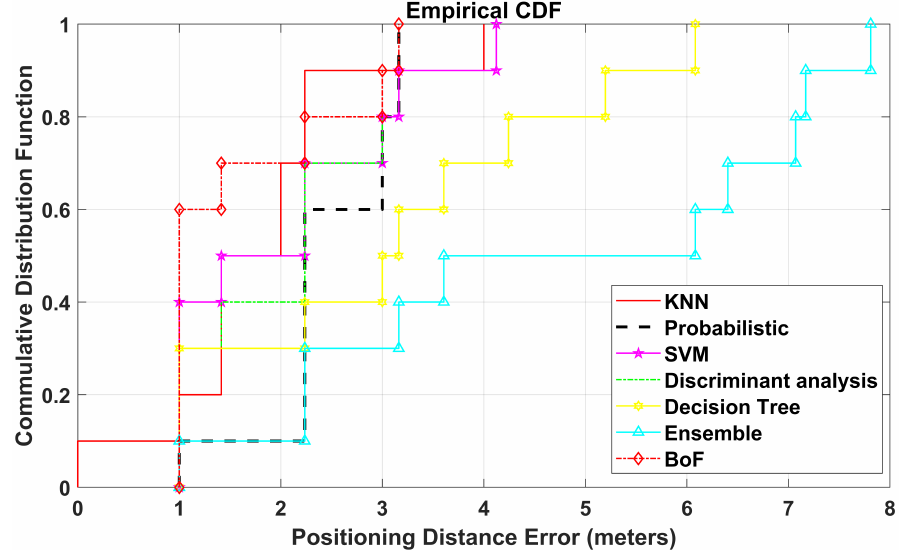
Figure 11. CDF Plot for real-time experiment. Table 5. Mean absolute error in the real environment.